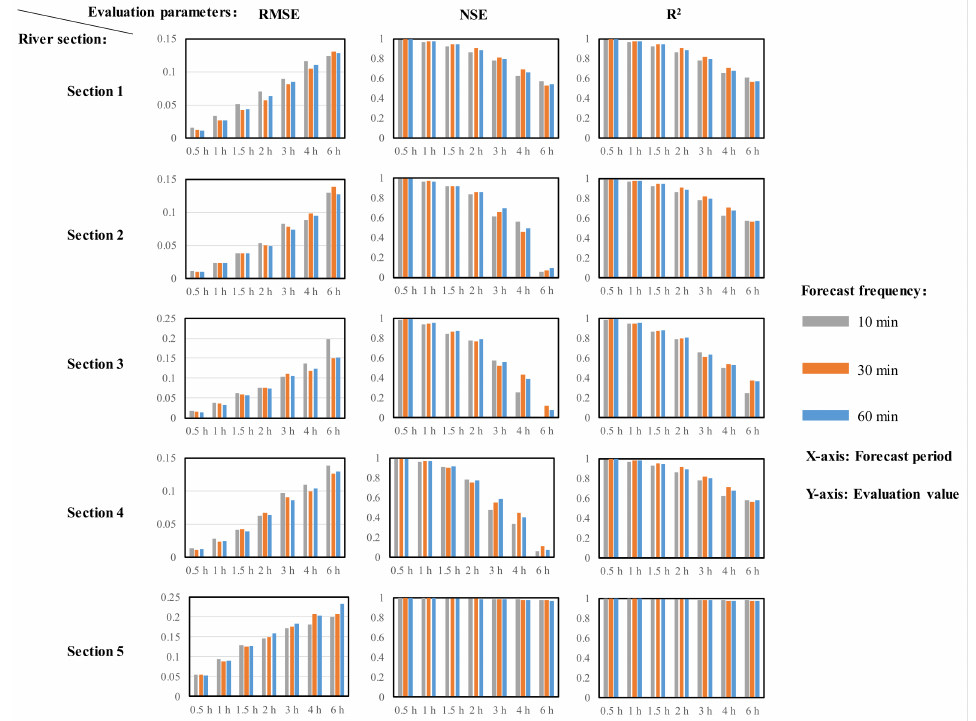
Figure 6. Model evaluation under different forecast periods and rolling